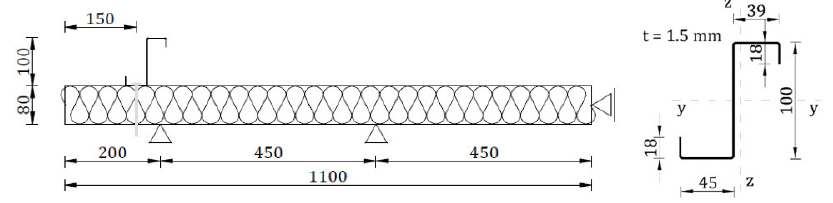
Figure 1. Test bed scheme—geometry of the sandwich panel and the thin ‐ walled Z ‐ beam.